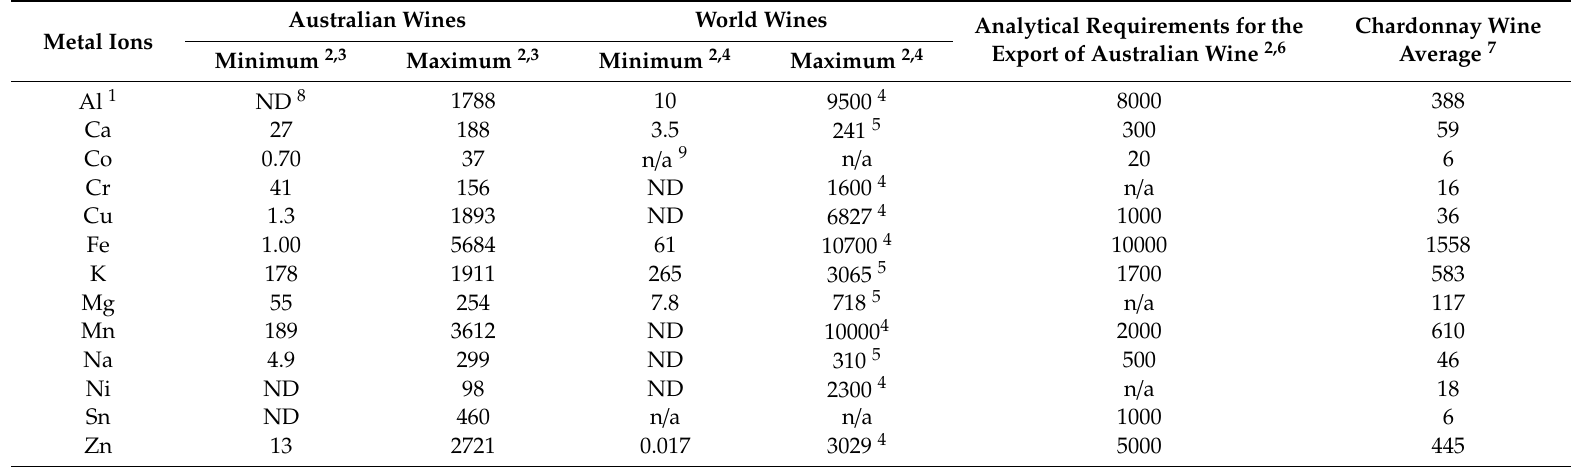
Table 1. Minimum and maximum concentrations of metal ions measured in this study in Chardonnay wines post-bottling, as well as those of Australian wines and wines from the rest of the world. Limits for the concentrations of the metals for the export of Australian wine are also reported. Metal